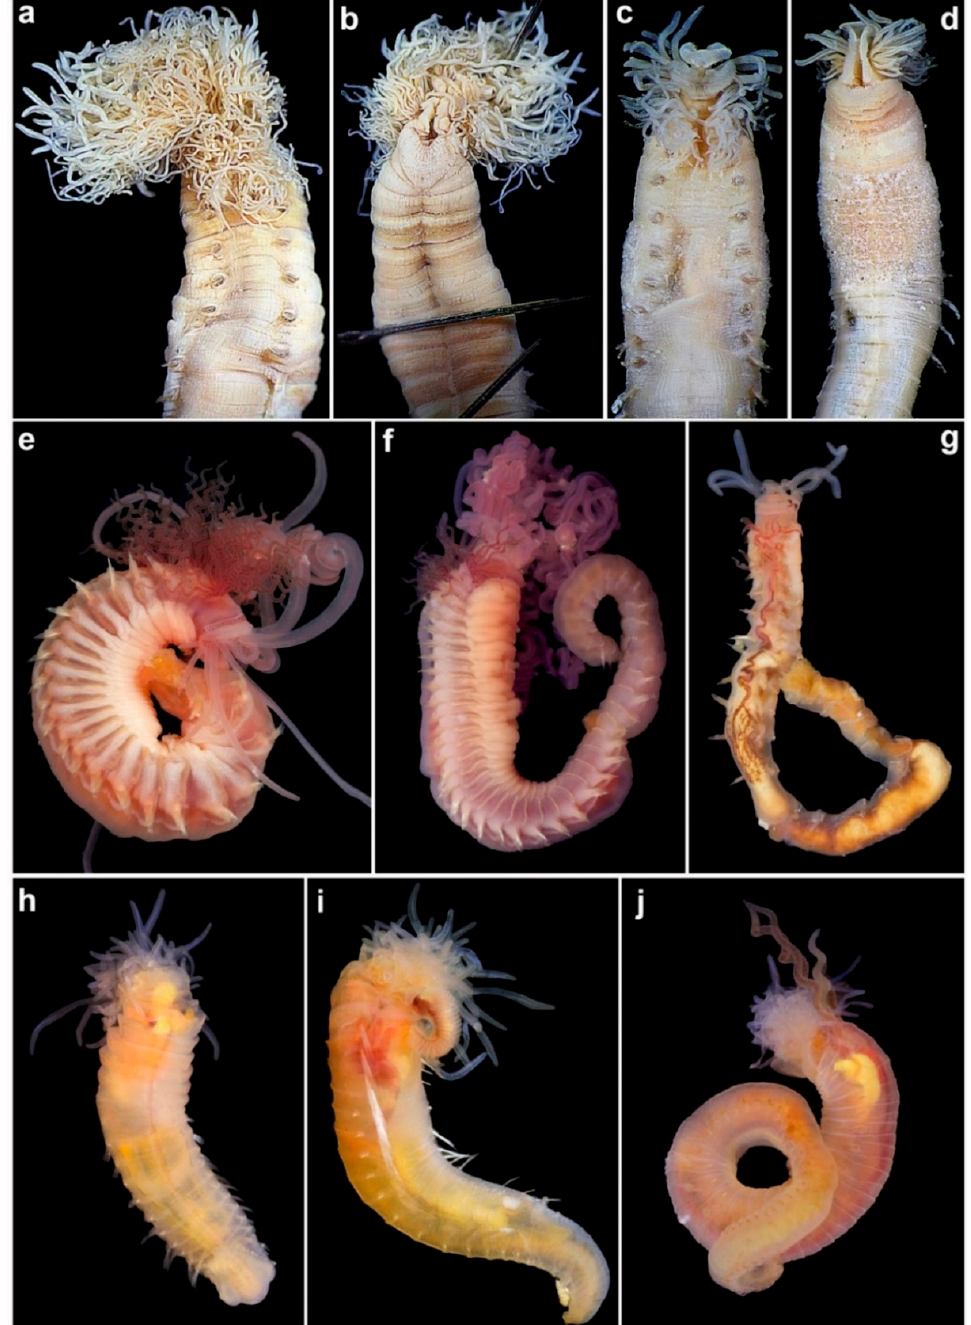
Figure 2. Diversity of Terebelliformia: Telothelepodidae (TE), Thelepodidae (TH) and Trichobranchidae (TR): ( a , b ) Telothele- pus capensis (topotype NHMUK ANEA 1955.12.30.1) (TE): anterior end, dorsal and ventral views, respectively; ( c , d ) Rhinothelepus mexicanus (holotype LACM-AHF Poly 1449) (TE): anterior end, dorsal and ventral views, respec- tively; ( e , f ) Thelepus paiderotos (AM W.44600 and AM W.44283, respectively) (TH): entire live worms in right lateral and ventro-lateral views, respectively; ( g ) Streblosoma curvus (paratype AM W.44287) (TH): entire live worm (incomplete), dorsal view; ( h , i ) Terebellides akares (paratype AM W.45450) (TR): ventral and left dorso-lateral views, respectively, of live animals; ( j ) Trichobranchus hirsutus (AM W.45444) (TR): complete live worm, left lateral view. Photos: ( e – j )—A.